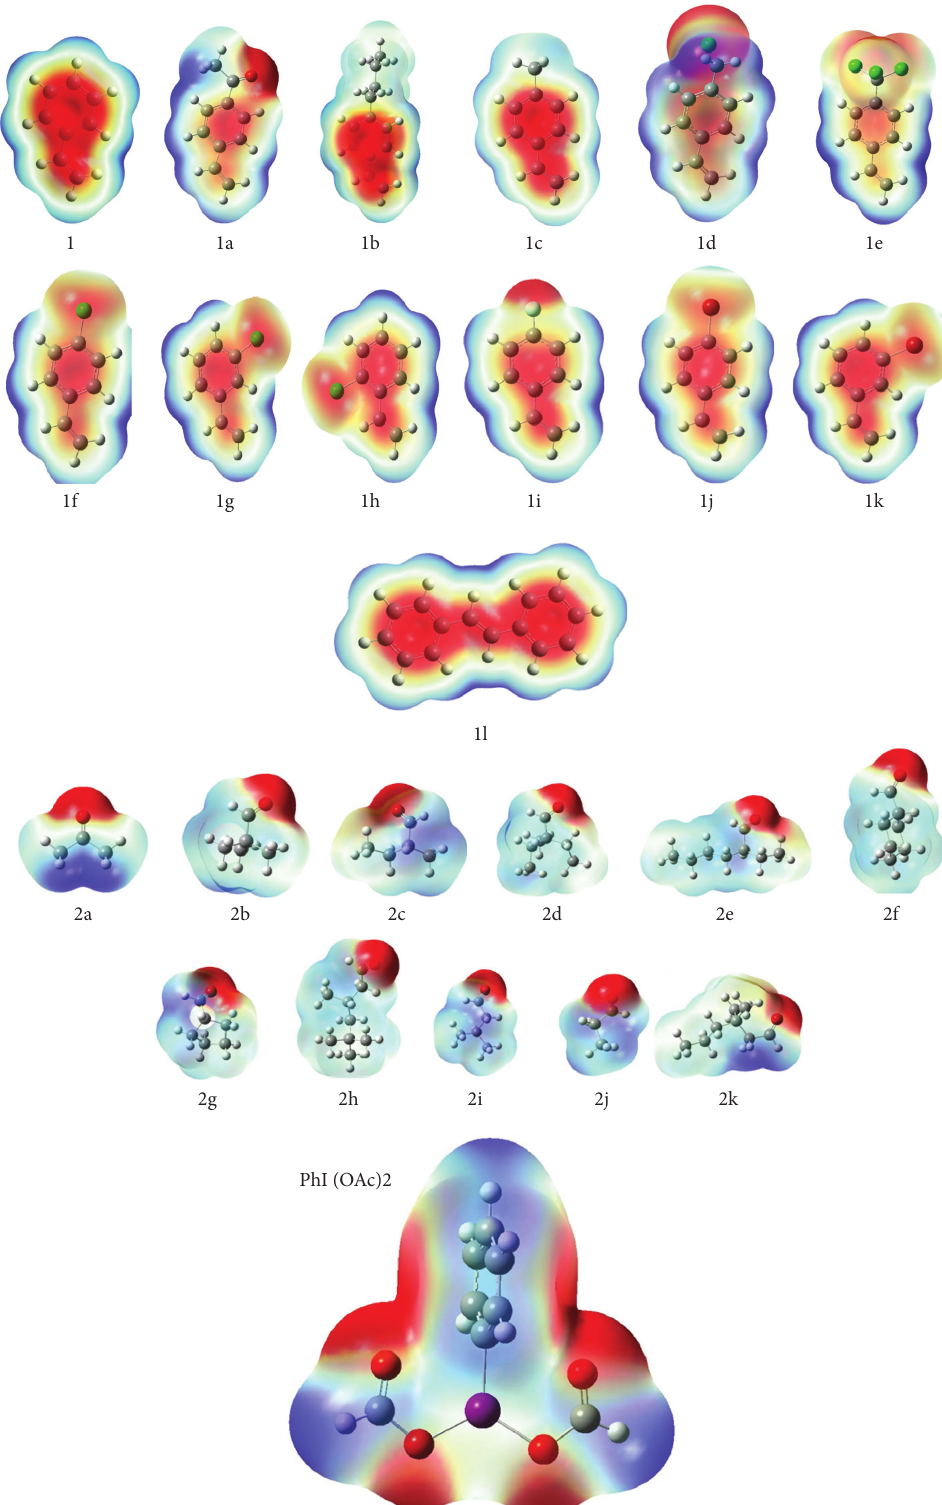
Figure 5: Electron density (isovalue � 0.004), mapped with molecular electrostatic potential (color scheme: red for negative surface map values and blue for the positive ones) for styrene and aldehyde